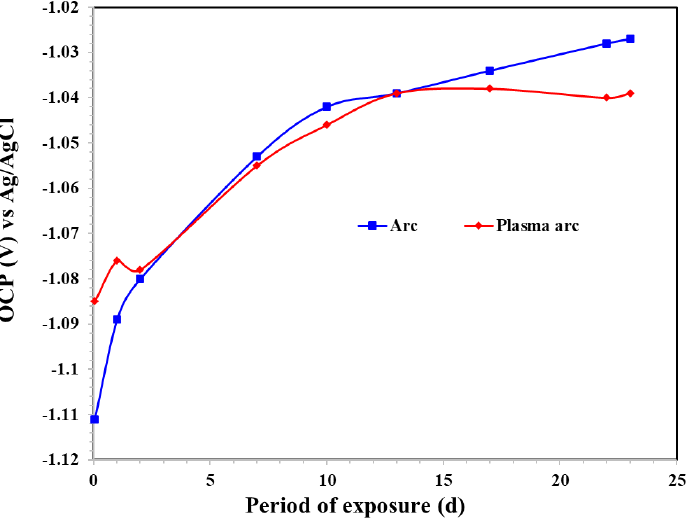
Figure 6. OCP of the Zn coatings in artificial seawater for different exposure periods.